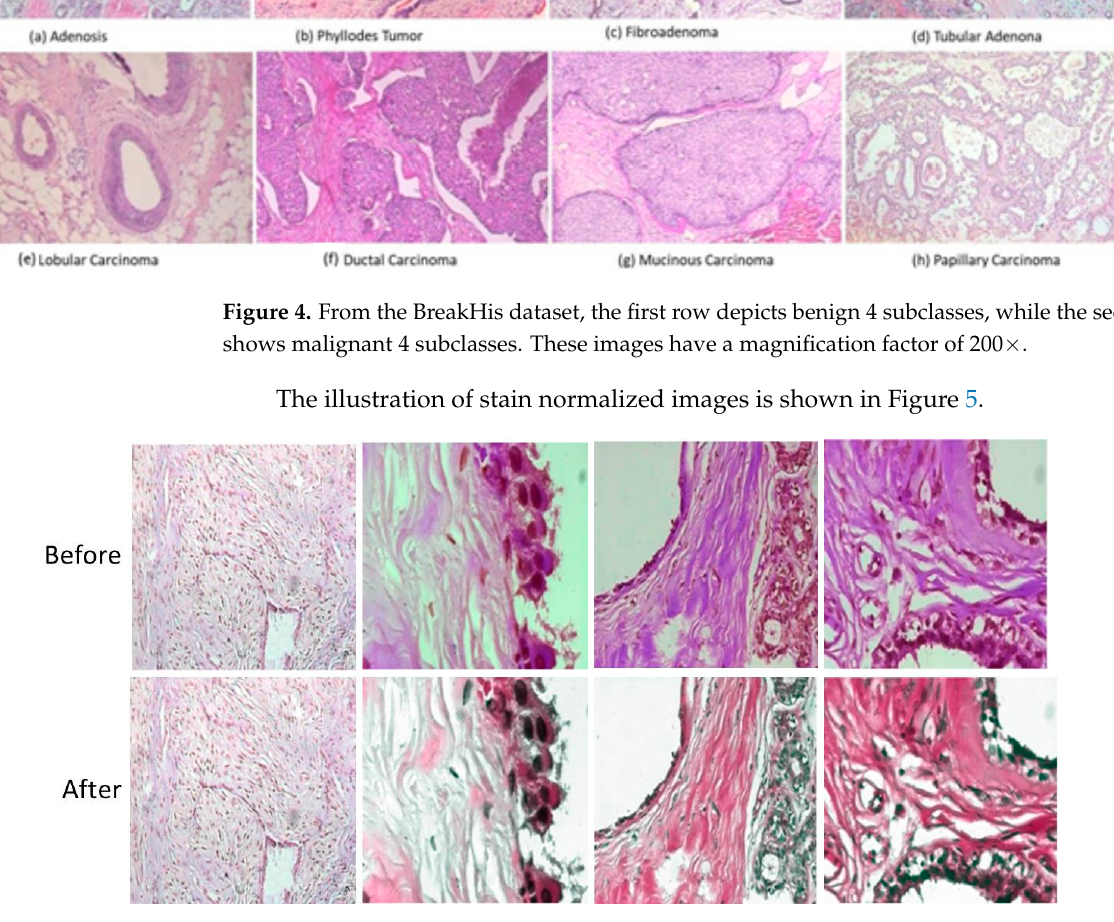
Figure 5. Stain normalized images of 4 different subcategories at a magnification factor of 400×.